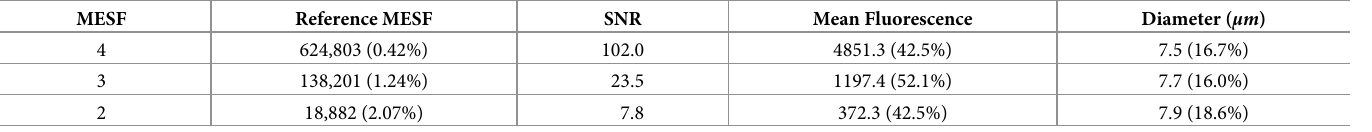
Table 1. Mean fluorescence and diameter of different groups of beads. Reference MESF refers to bead intensity as measured by the manufacturer. The coefficients of variation for each measurement are shown in parenthesis.